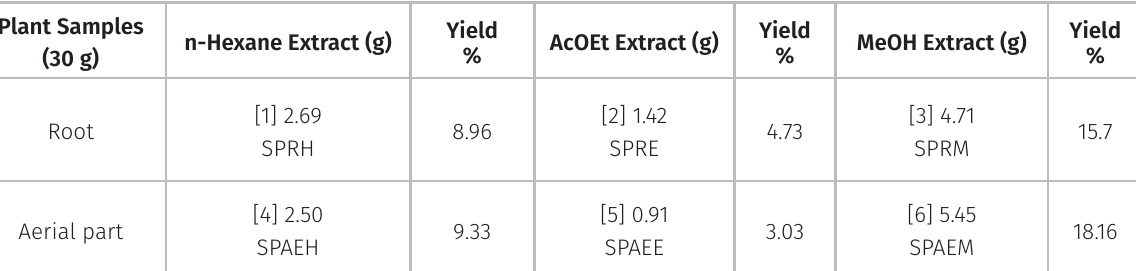
Table I. The amounts of extracts from the different polarity of solvents. Plant Samples